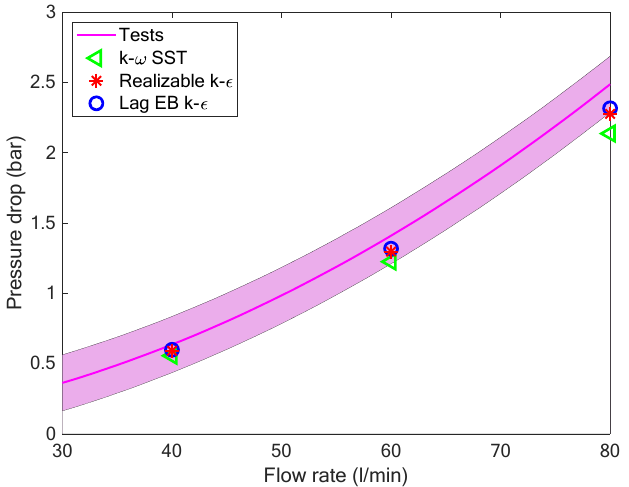
Figure 8. Comparison between the measured hydraulic characteristic of the cylindrical mock-up equipped with MCs (solid line with shaded area) and that computed using different turbulence models (symbols).